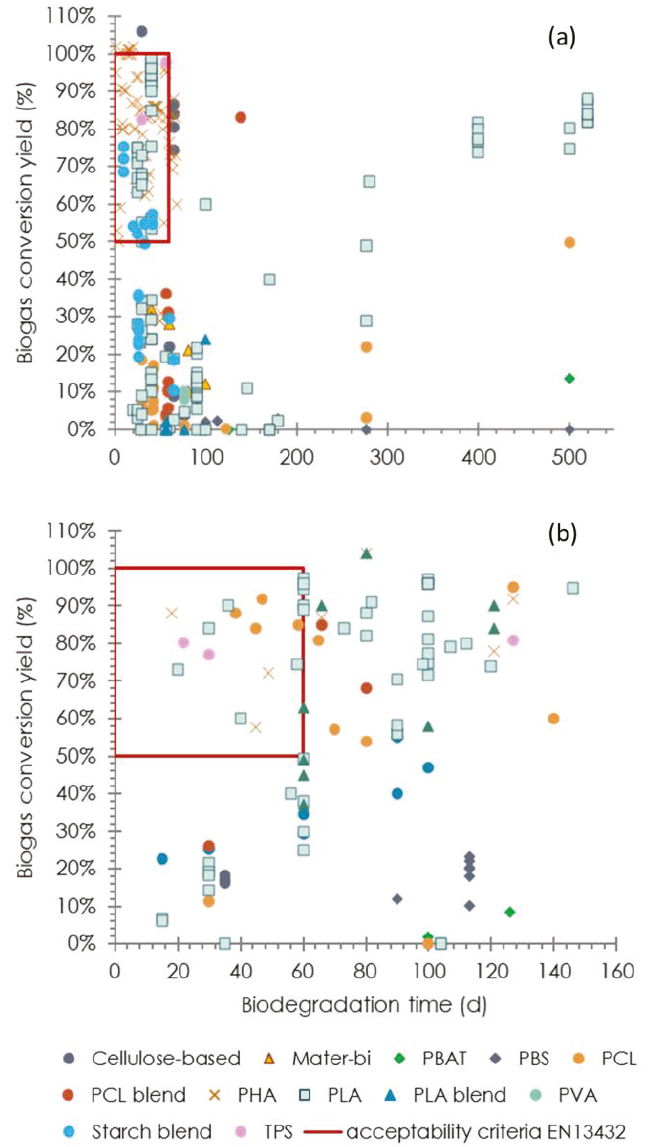
Figure 7. Trends of the biodegradation degree over digestion time under ( a ) mesophilic and ( b ) thermophilic